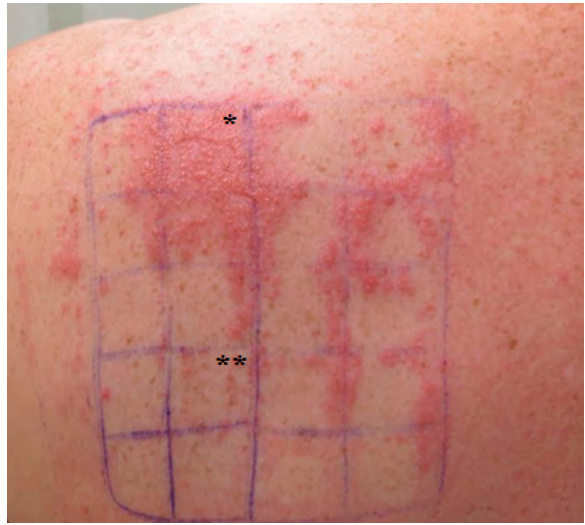
Figure 1. Strong positive patch test reaction (+++) to castor oil (‘as is’) (*), but not to castor wax